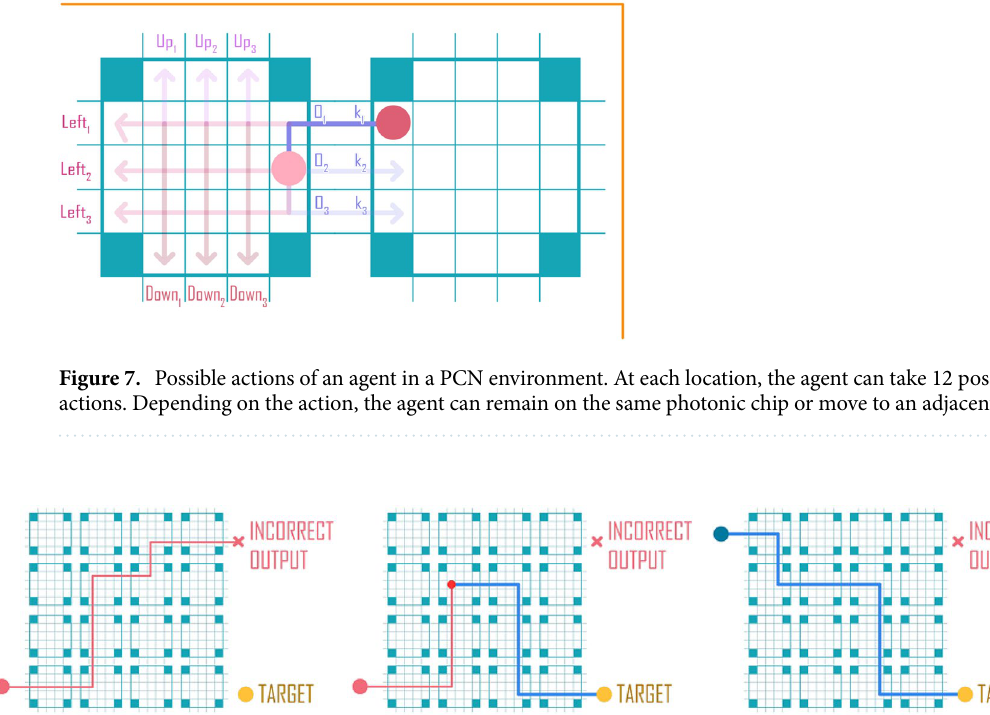
Figure 8. Learning the episode that corresponds to a failed routing. Left: a failed route that does not lead to the target destination. Middle: a new successful route obtaining by replacing the second part of the failed route with that of the successful one. Right: a successful route from the Sample Extraction Buffer